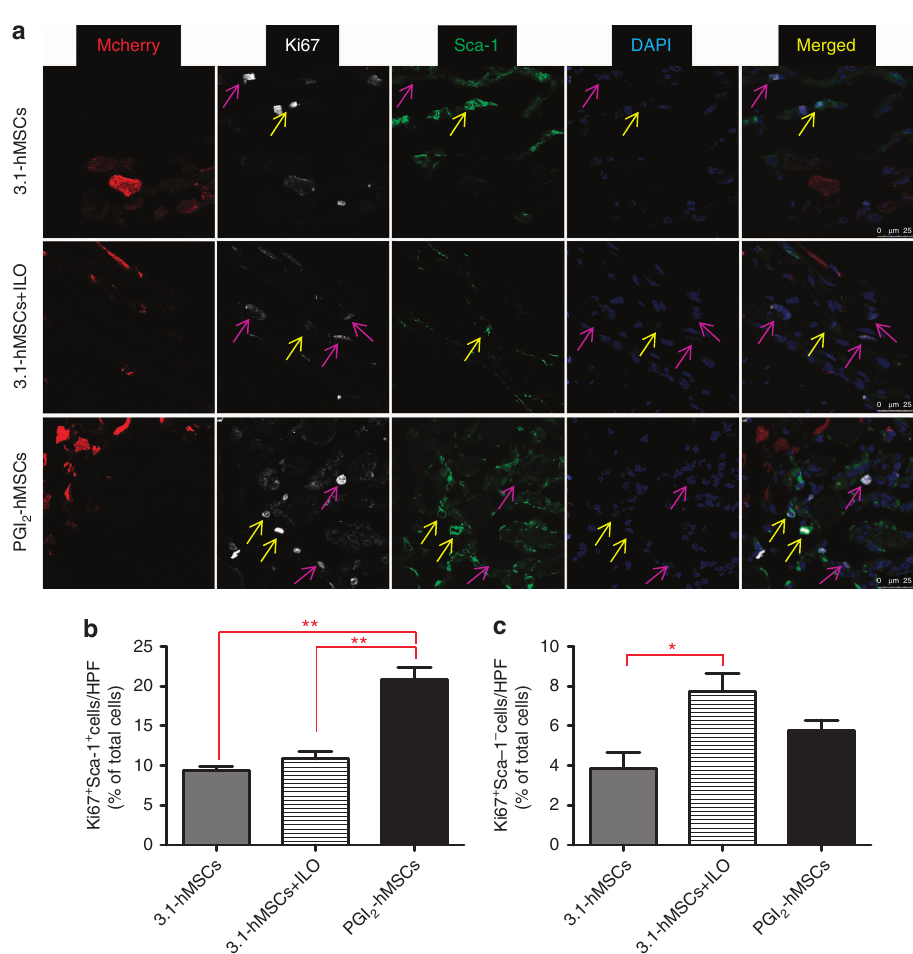
Figure 5 | Significantly higher numbers of endogenous proliferating Ki67 þ Sca-1 þ cells were located adjacent to the PGI 2 -hMSC site 3 days after cell injections. ( a ) Representative confocal images illustrate the distribution of endogenous Ki67 þ Sca-1 þ (yellow arrows) and Ki67 þ Sca-1 (cid:3) cells (purple arrows) in ischaemic gastrocnemius muscle areas surrounding injected hMSCs. ( b ) Quantitative analysis indicated a significantly higher percentage of Ki67 þ Sca-1 þ cells surrounding PGI 2 -hMSCs injection sites as compared with 3.1-MSCs þ ILO or to 3.1-hMSCs sites (** P o 0.01; one-way ANOVA with Newman–Keuls post hoc test). ( c ) Significantly higher percentage of Ki67 þ Sca-1 (cid:3) cells surrounded 3.1-MSCs þ ILO injection sites than 3.1-hMSC injection sites (* P o 0.05; one-way ANOVA with Newman–Keuls post hoc test). No significant differences were seen between 3.1-MSCs þ ILO and PGI 2 -hMSC treatment or between PGI 2 -hMSC and 3.1-hMSC treatment. Data are shown as mean ± s.e.m. A total of 30 high-power fields (HPFs) from three mice (male and female) per treatment group (10 HPFs per mouse, see details in Method) was used. Mice were sex matched among the three treatment groups. Scale bar, 25 m